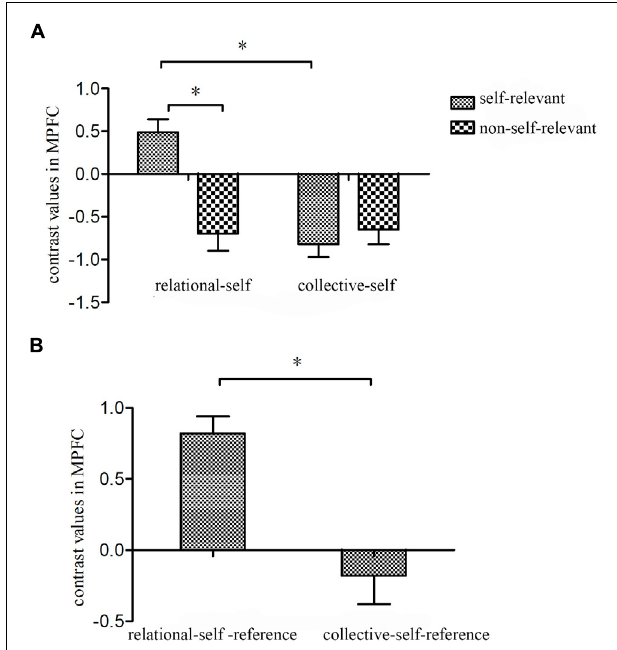
FIGURE 5 | Represent fMRI signal changes in ROI in the self- and non-self-relevant information processing conditions for both relational- and collective-self. Error bars denote standard errors. (A) Represents fMRI signal changes in MPFC in the self-relevant and non-self-relevant conditions relative to valence condition; (B) Represents the differential fMRI signal changes in MPFC for relational-self- and collective-self-reference. ∗ p <